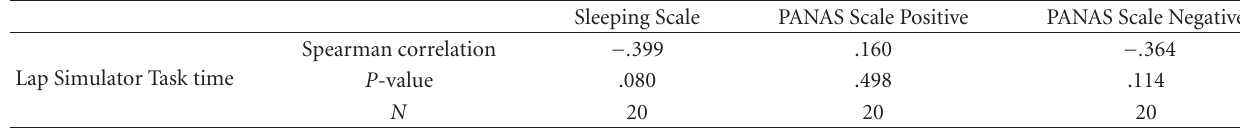
Table 2: Impact of sleep and mood on laparoscopic performance.